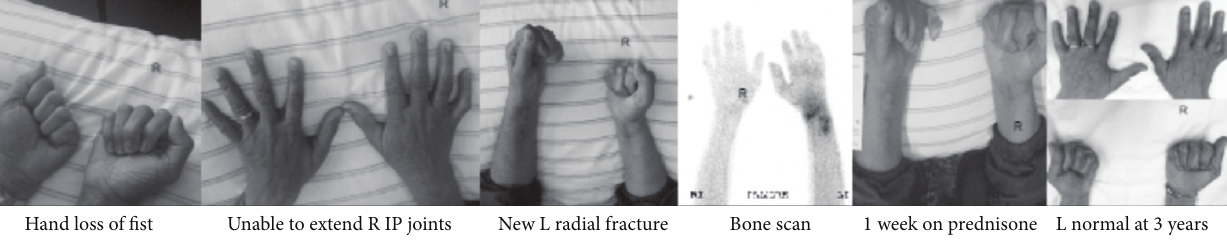
Figure 2: Case 2 : a 50-year-old diabetic woman fell on ice fracturing her right wrist requiring open reduction internal fixation (ORIF). She developed capsular swelling in the right hand and lack of full flexion and extension at the interphalangeal joints; hand therapy was provided. When assessed 10 months after the accident, there was ongoing loss of range of motion. Shortly after, a motor vehicle accident resulted in a left radial fracture with an ORIF, with capsular restrictions in the wrist and hand, and loss of supination. A bone scan showed activity on the left only. Prednisone was initiated with little change on the old right injury but resolution of pain and loss of range on the new left injury.